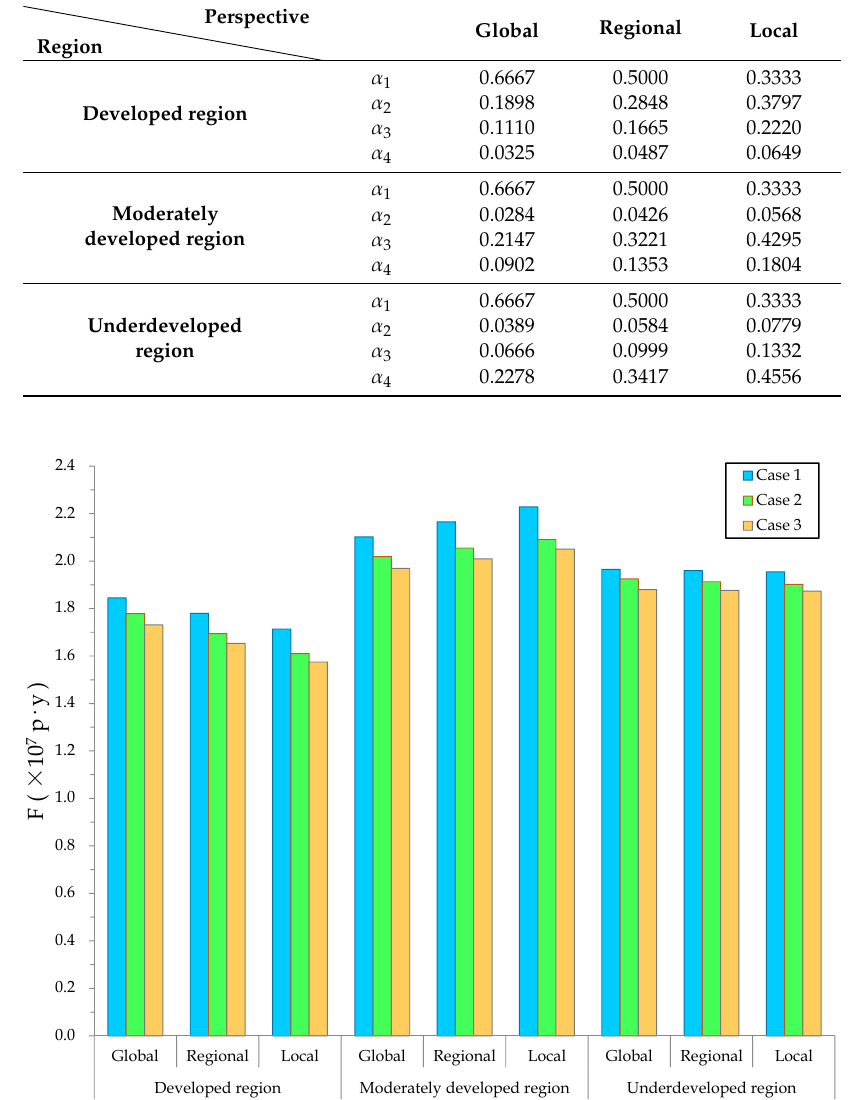
Table 20. The weight vector of PEC, GWP, AP, and REP in di ff erent regions and from di ff erent perspectives.